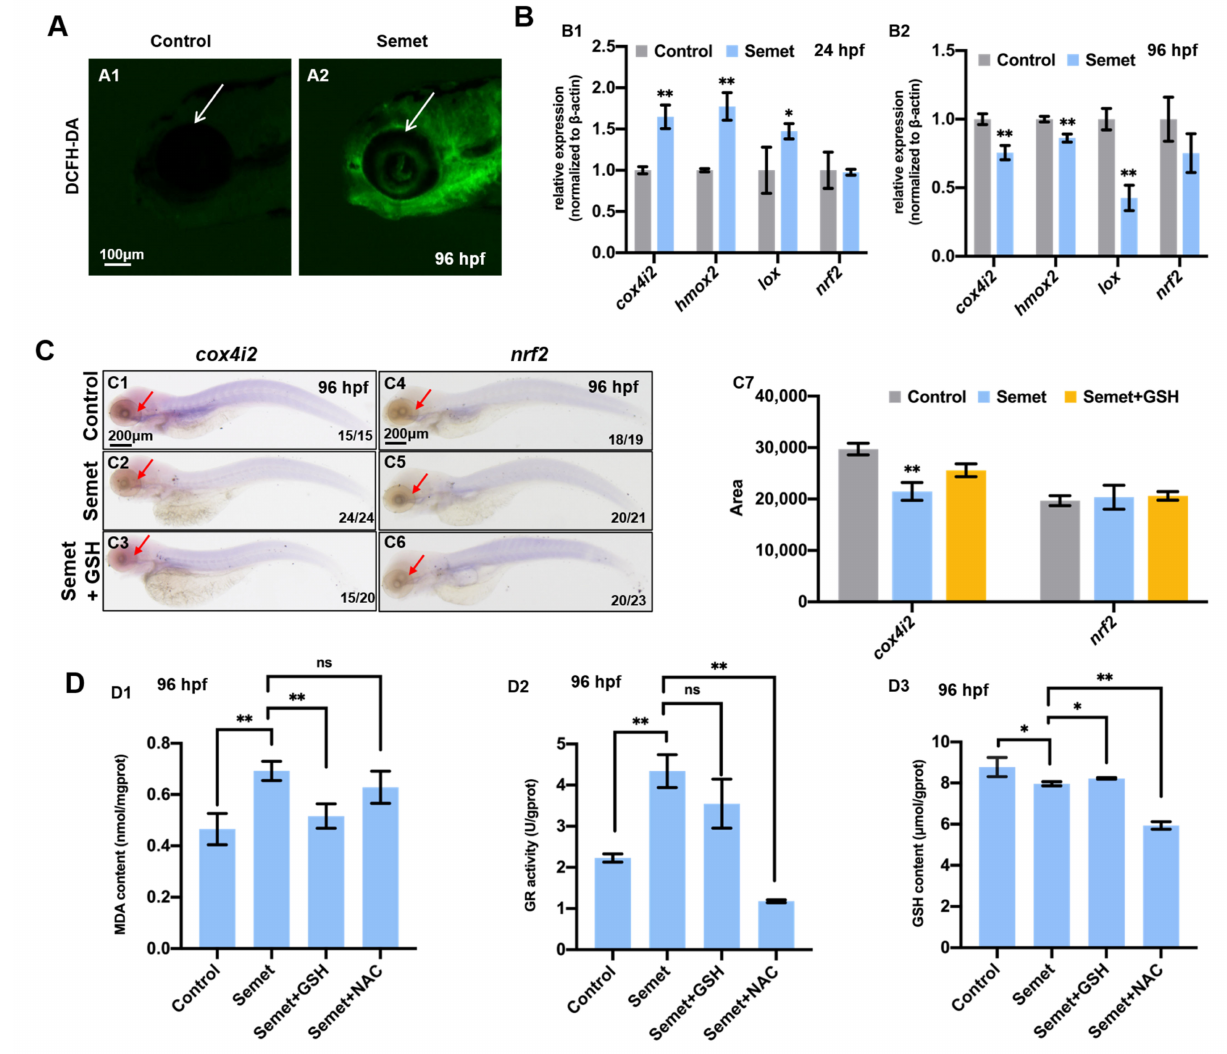
Figure 2. Oxidative stress in selenium-treated embryos. ( A ) ROS levels in control and selenium- treated embryos at 96 hpf were indicated by DCFH-DA staining. ( B ) Expression of oxidative stress marker genes in control and selenium-treated embryos at 24 hpf ( B1 ) and 96 hpf ( B2 ). ( C ) WISH data of cox4i2 and nrf2 in embryos from control, semet and semet plus GSH groups at 96 hpf ( C1 – C6 ). Quantification analysis of the WISH data in different samples ( C7 ). ( D ) MDA content ( D1 ), GR activity ( D2 ) and GSH content ( D3 ) in control, semet, semet plus GSH and semet plus NAC embryos at 96 hpf. **, P < 0.01; *, P <